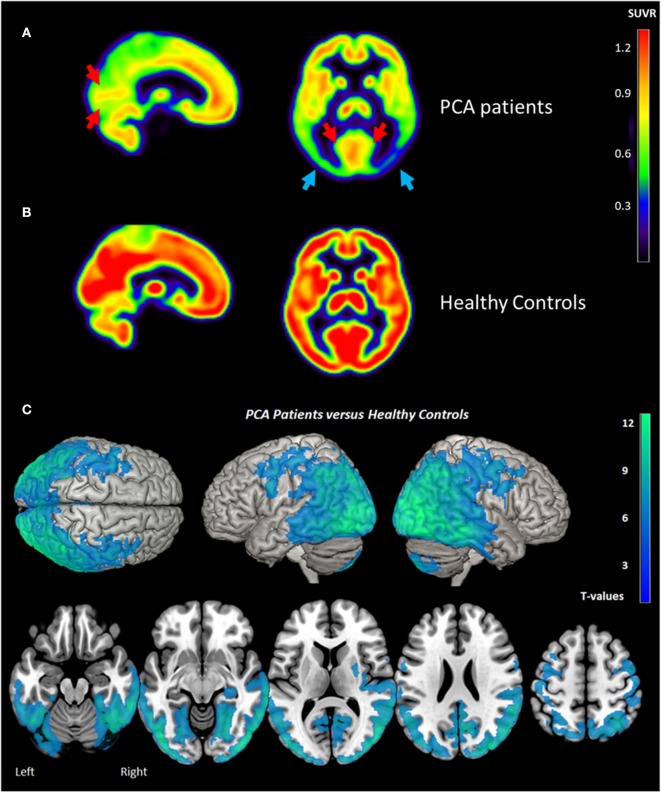
Brain metabolism in PCA Patients (A), Healthy Controls (B), and comparison between PCA patients and Healthy Controls (C) measured by [18F] FDG PET. “Occipital tunnel sign” is represented by preserved uptake in the medial occipital areas (red arrows) in comparison to lateral occipital (blue arrows). Metabolism asymmetry with right predominance (blue arrows) is also found in PCA patients. (A,B) represent the mean of PCA patients (n = 15) and healthy controls (n = 18), respectively. The statistical threshold for group comparison is pFWE-corr < 0.05 (k > 50 voxels). PCA, posterior cortical atrophy; SUVR, Standard Uptake Value Ratio.